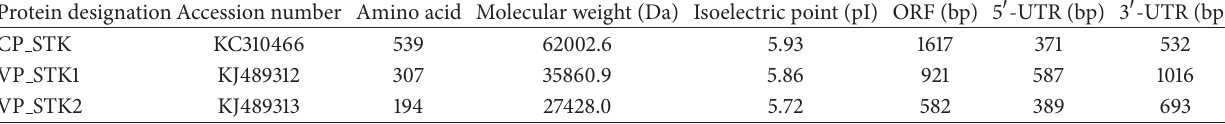
Table 2: Physicochemical properties of whole